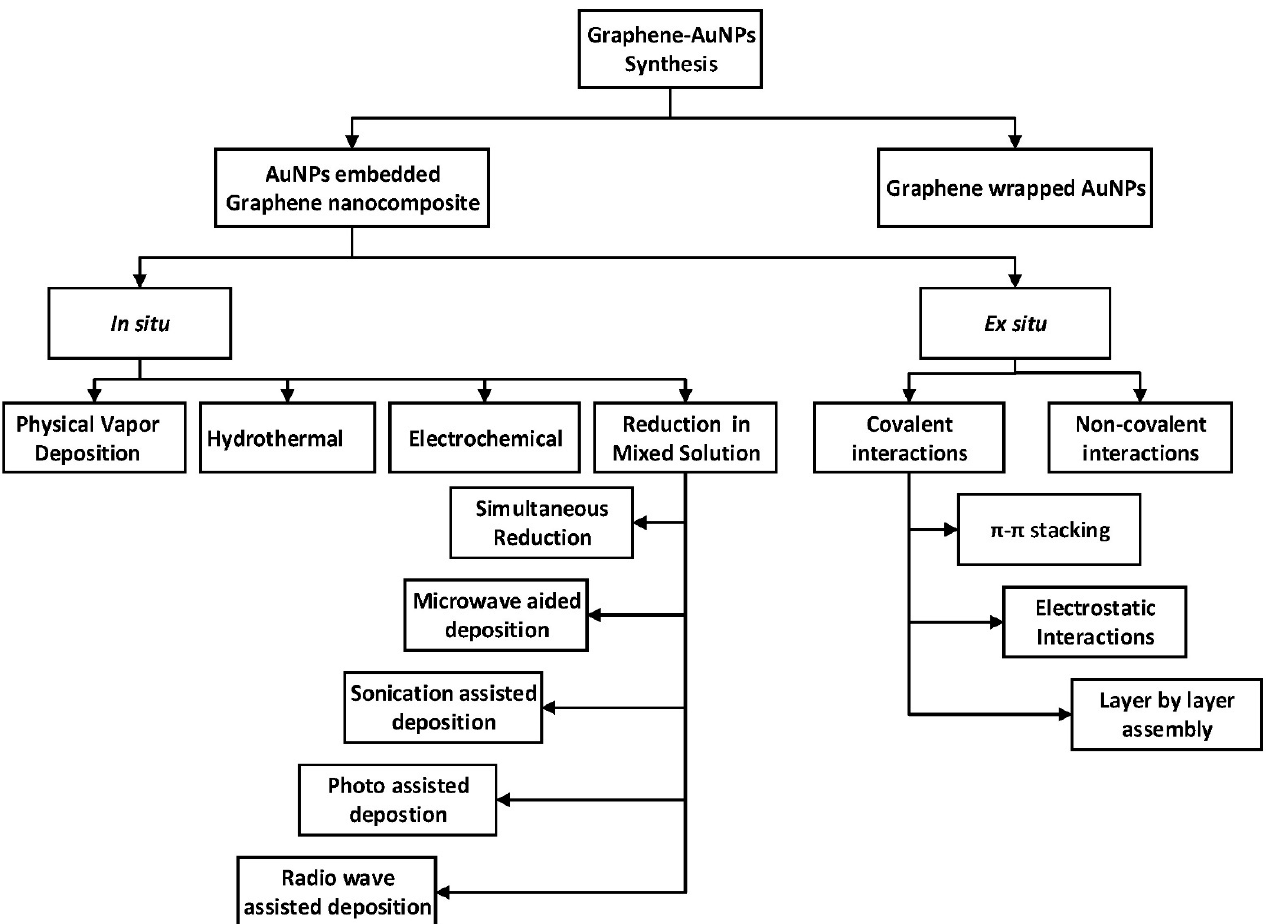
Figure 3. Schematic representation of the formation of graphene–AuNPs nanocomposites [161].